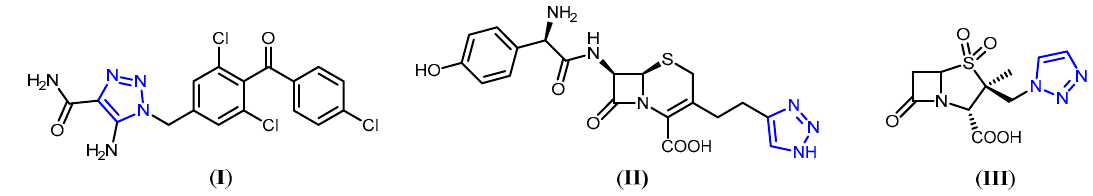
Figure 1. Chemical structures of pharmaceutical drugs containing 1,2,3-triazole rings.